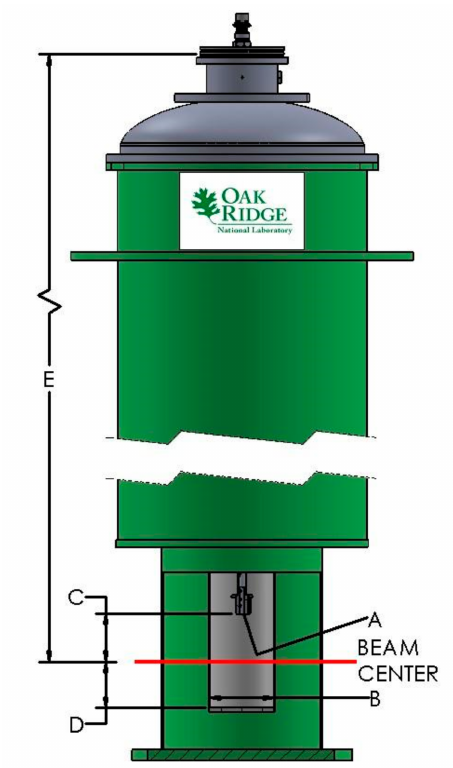
Figure 2. ILL Niobium Foil Vacuum Furnace. Temperature range of 30–1500 ◦ C (A) Interface connection M8 × 1.25 (male) (B) Bore size diameter = 50 mm (C) Distance interface to beam center = 31.75 mm (D) Beam center to sample space bottom = 11.862 cm (E) Distance stick flange to beam center = 41.275